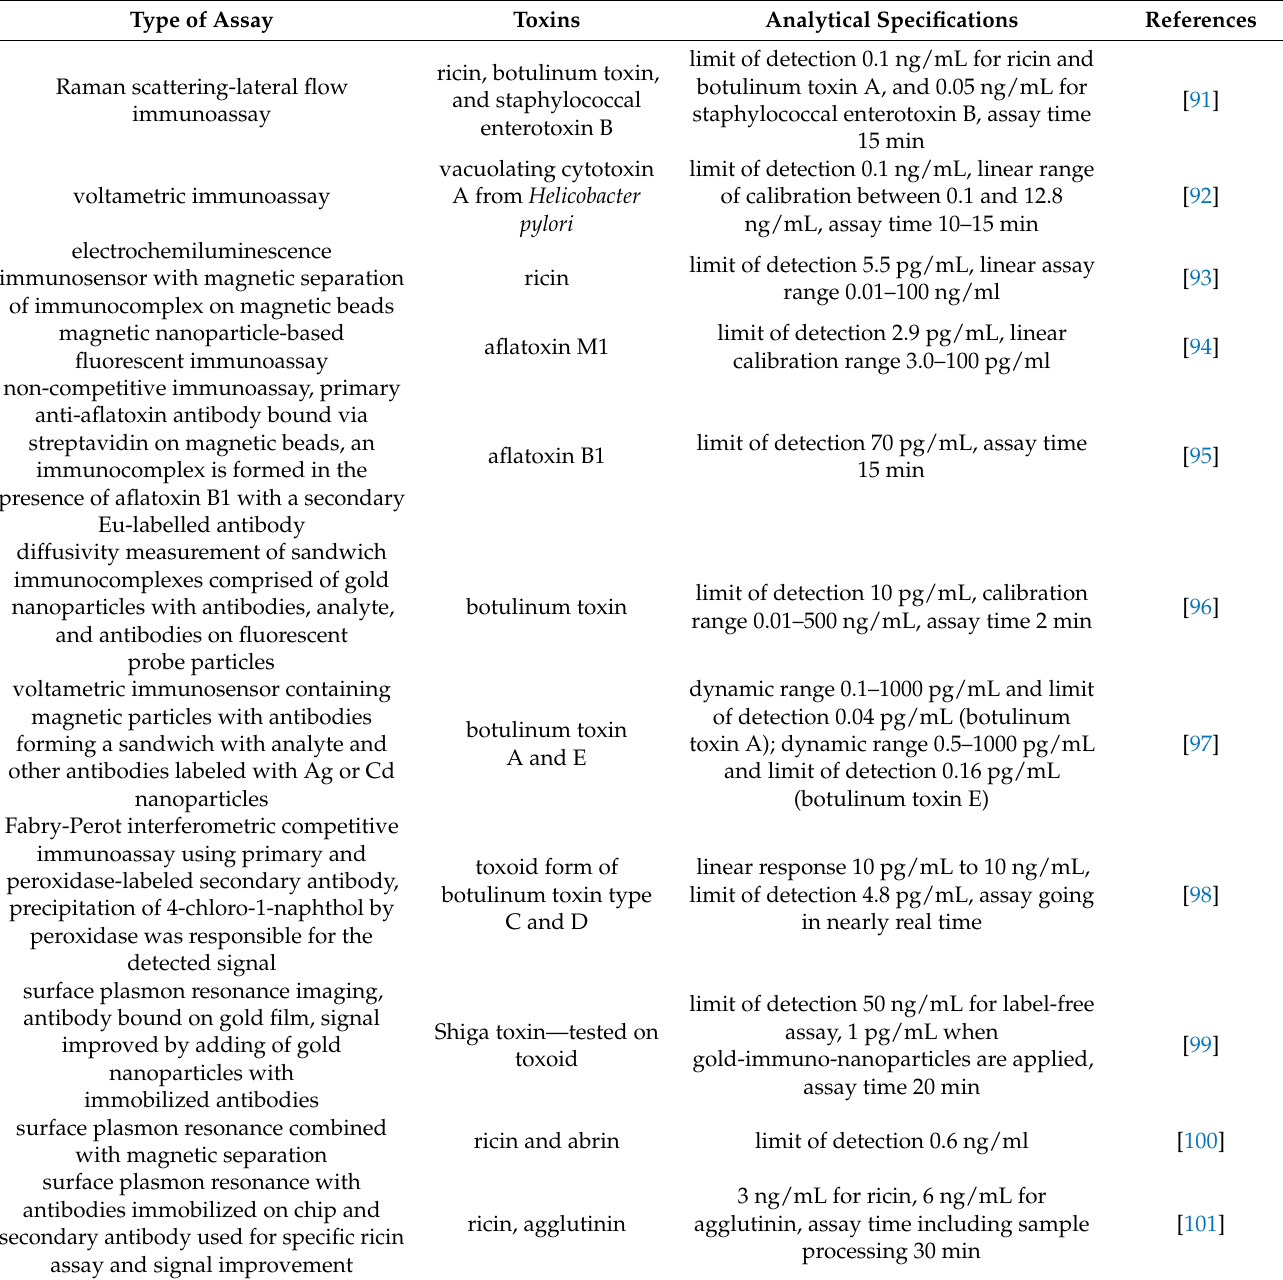
Table 3. New immunosensors for toxic biological warfare agents